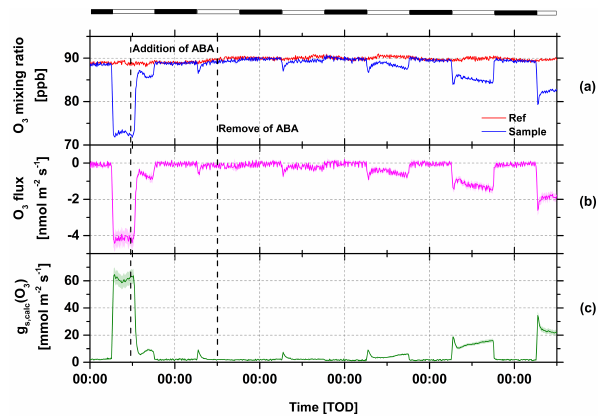
Figure 12. PAN mixing ratio (a) , PAN flux (b) and stomatal con- ductance to PAN (c) for Quercus ilex treated with 350µM ABA- nutrient solution. The diurnal cycle of light was simulated by a cli- mate cabinet with 13h light period (white area) and 11h dark period (grey shaded area). RH inside both cuvettes was around